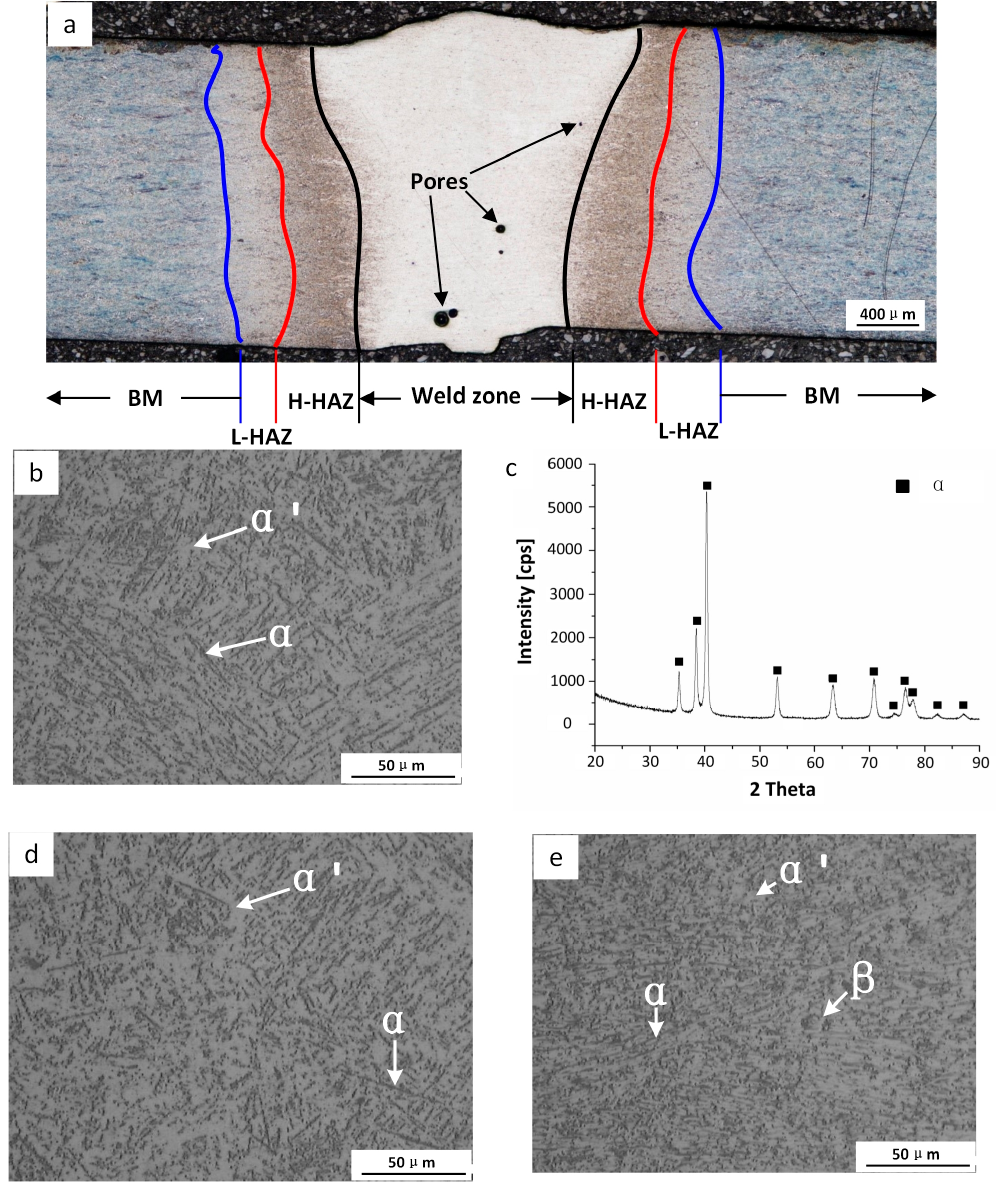
Figure 4. Macro and microstructure of joint and X-ray diffraction pattern: ( a ) macrostructure; ( b ) microstructure of the welded region; ( c ) X-ray diffraction pattern of the welded region; ( d ) microstructure of high temperature heat affected zone; ( e ) microstructure of low temperature heat affected zone.